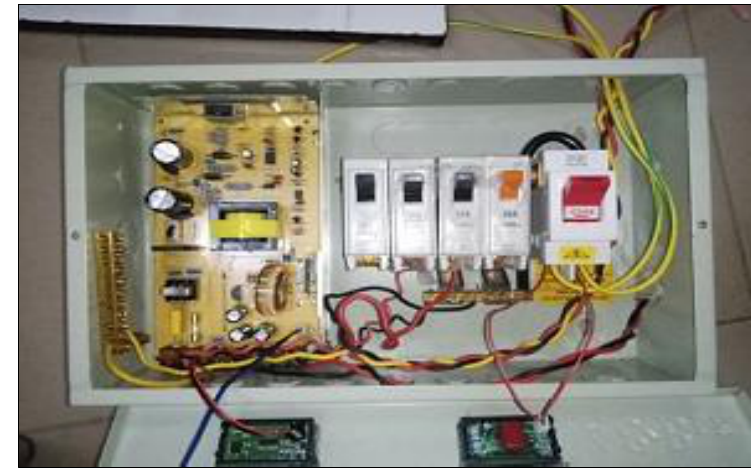
Figure 2: Internal Connection when all cables are connected.